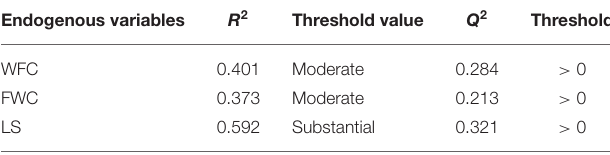
TABLE 4 | Coefficients of determination and predictive relevance. Endogenous variables R 2 Threshold value Q 2 Threshold WFC 0.401 Moderate 0.284 > 0 FWC 0.373 Moderate 0.213 > 0 LS 0.592 Substantial 0.321 >